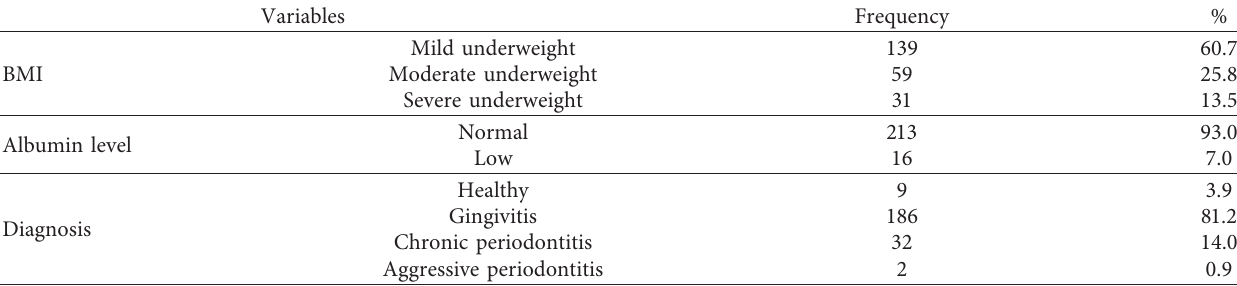
Table 2: BMI, albumin level, and periodontal diagnosis of the study sample.